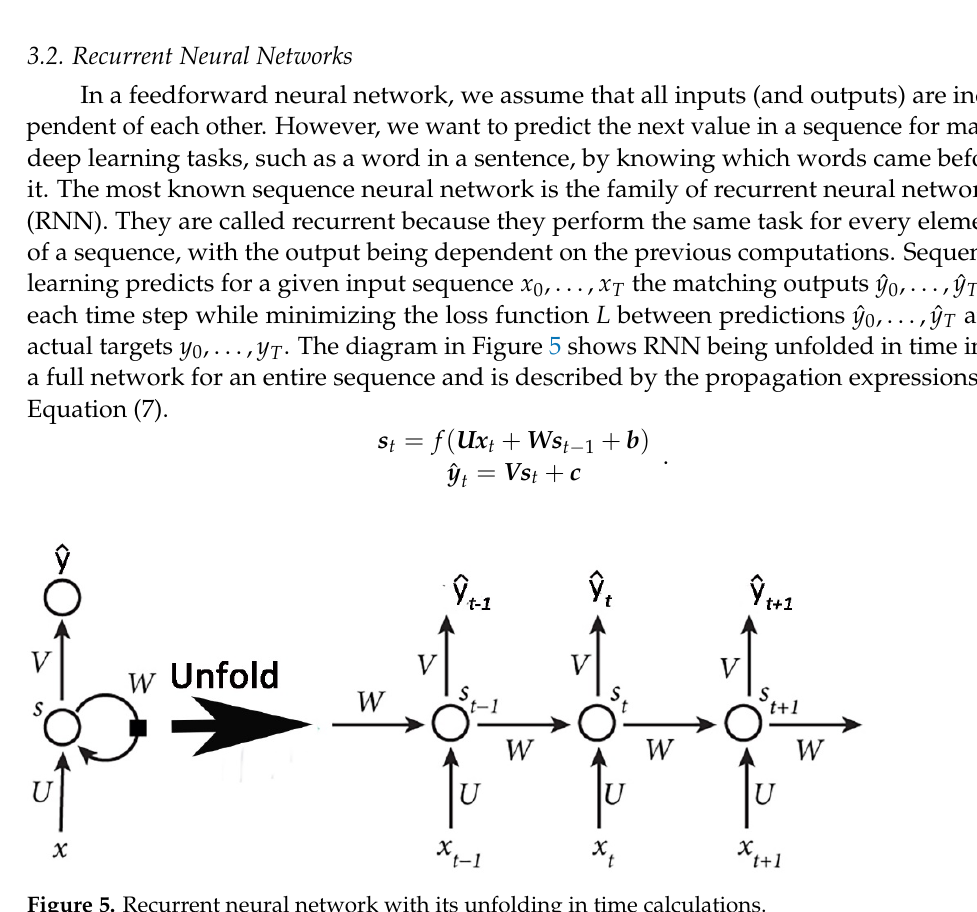
Figure 5. Recurrent neural network with its unfolding in time